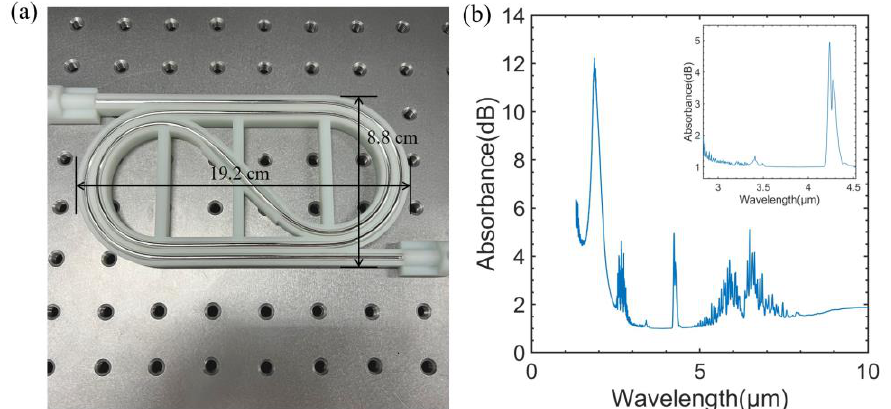
Figure 2. ( a ) Photo of the flexible HWG with 100 cm length. ( b ) Measured loss spectra of the HWG with 100 cm length.